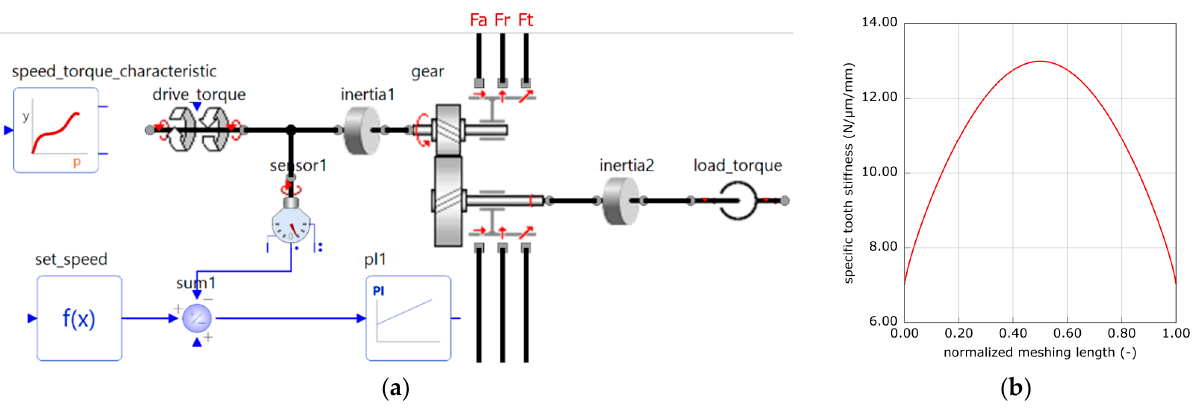
Figure 5. ( a ) Rotational system; ( b ) specific tooth stiffness for the mesh stiffness